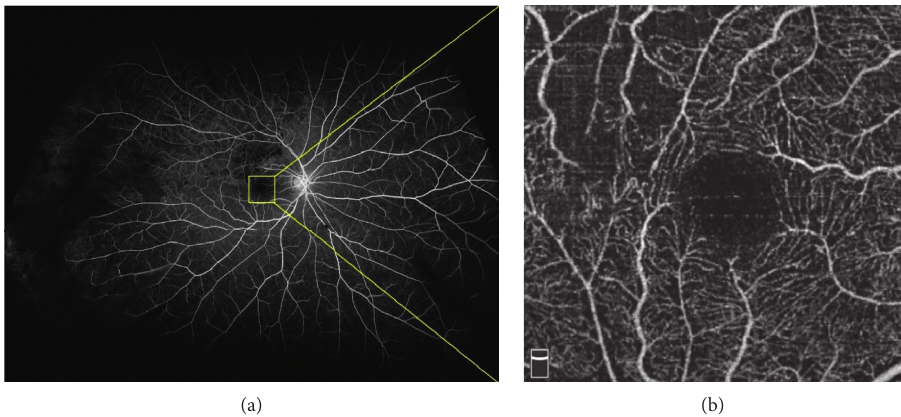
Figure 3: The UWFFA and OCTA images of a same patient with BRVO of the right eye. (a) The UWFFA image. The yellow square on the macula showed the scan area of OCTA. (b) The OCTA image of the same